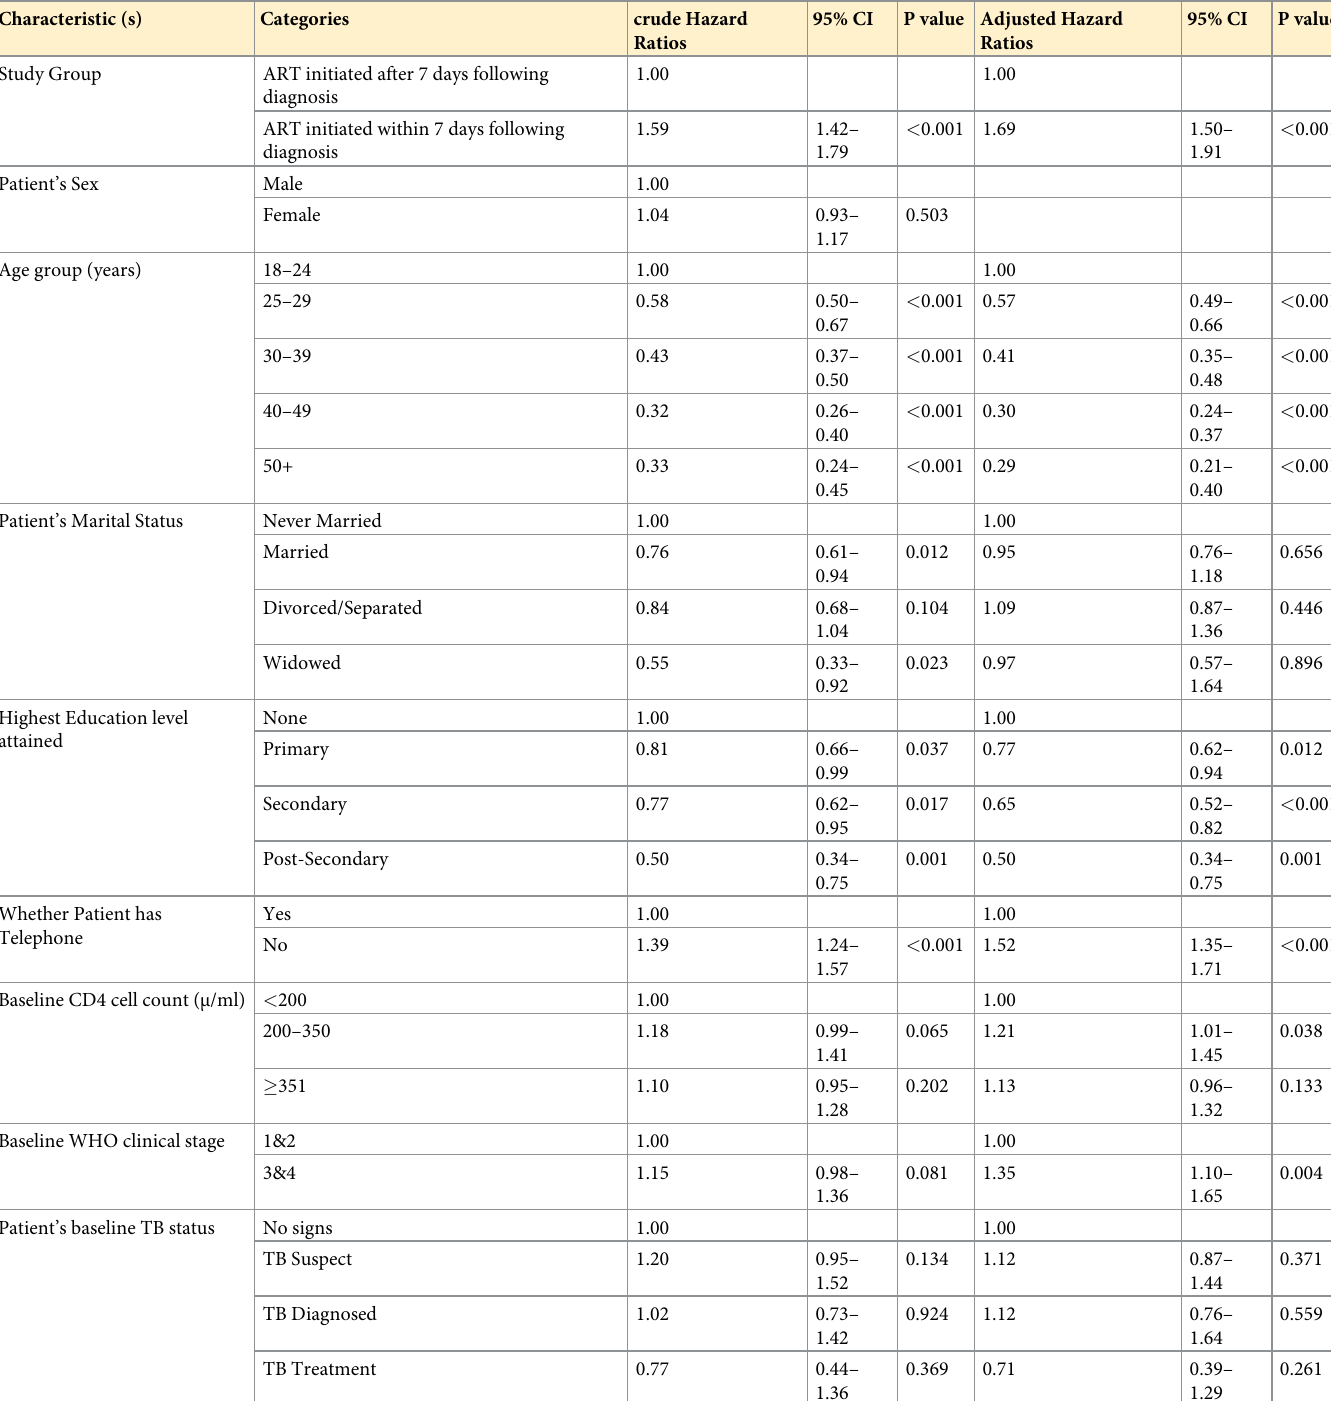
Table 3. Factors associated with loss to follow